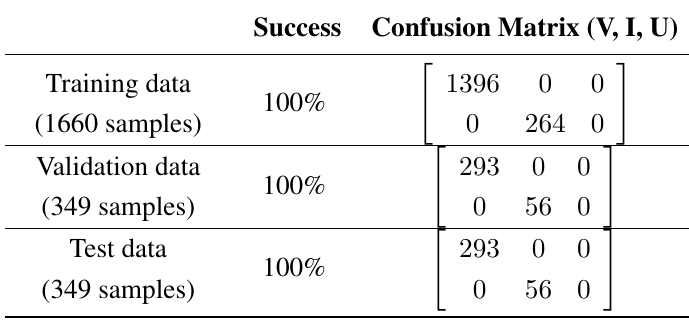
Table 3. Evaluation of the classifier for control lines in non-alcohol strip lateral histograms. Note that confusion matrices have dimensions of 2 × 3 because “undetermined” samples were never considered as an input. “Undetermined” samples are just the classification output when a certain confidence level is not reached.